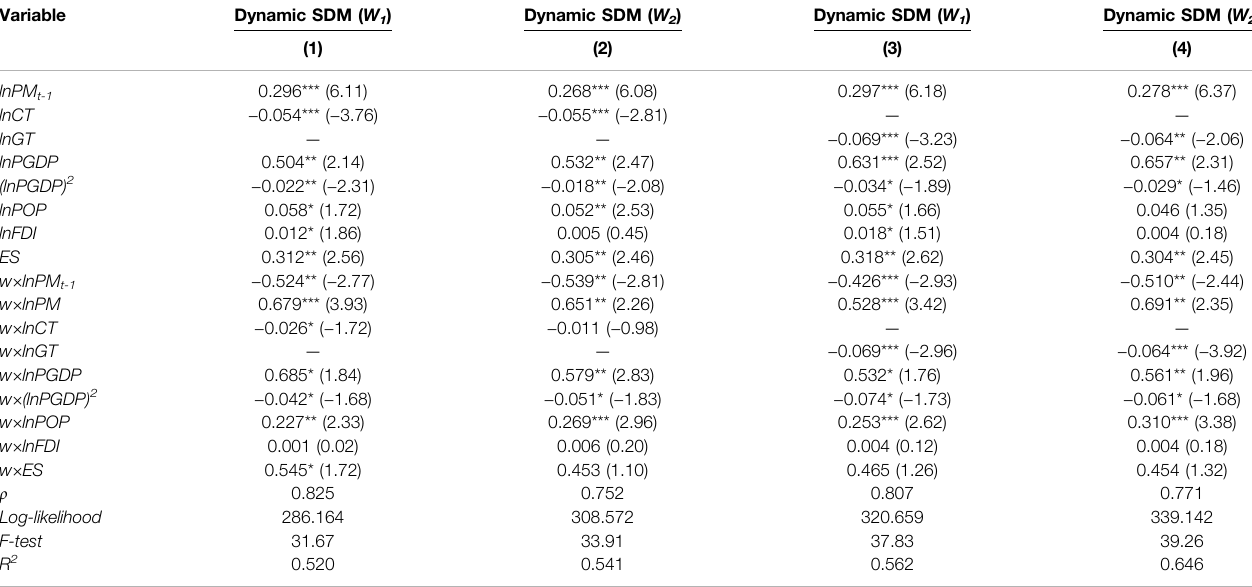
TABLE 7 | Different types of low-carbon tech-innovation on haze pollution.